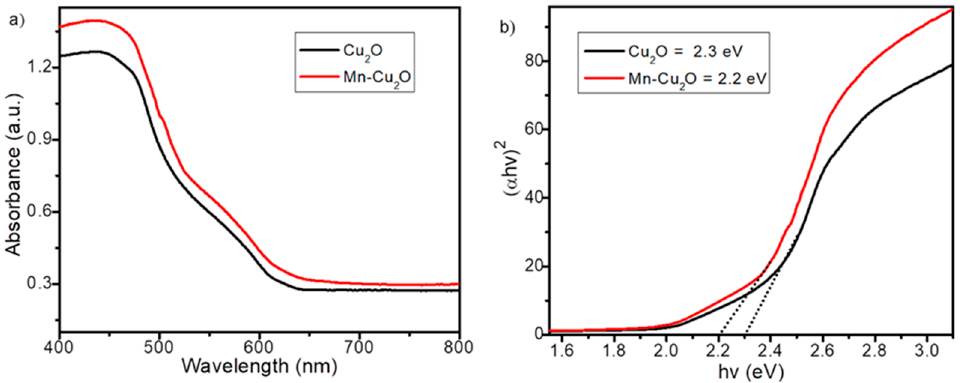
Table 2. Absorption edge and band gap energy of undoped and Mn-doped Cu 2 O nanoparticles.